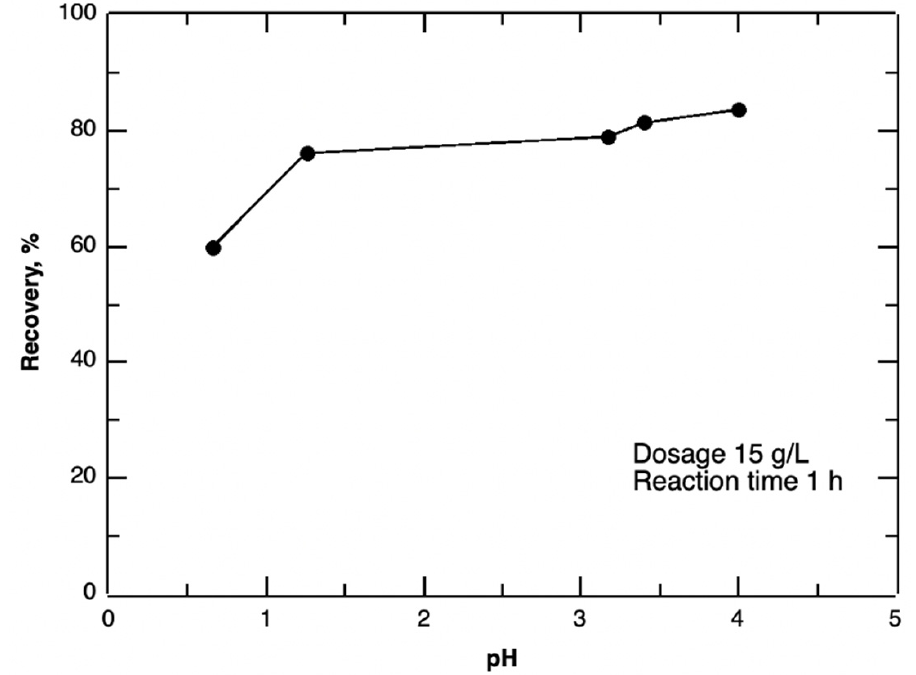
Figure 4. Effect of oxalic acid precipitation pH on REEs recovery at a fixed dosage of 15 g/L and reaction time of 1 h.